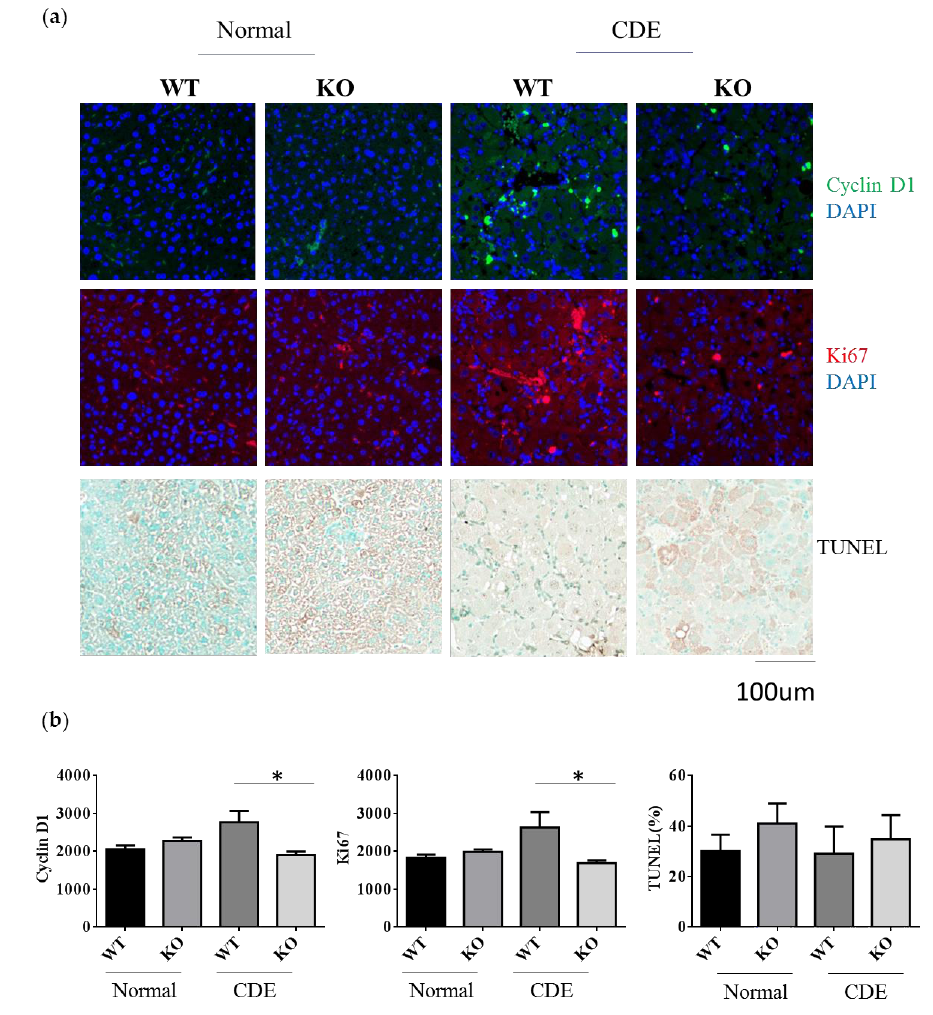
Figure 4. Reduction of cell proliferation in Erk2 −/− (KO) mice under the CDE diet. ( a ) WT and Erk2 −/− liver sections were stained with cyclin D1 and ki-67 with DAPI staining for nucleus. Liver sections